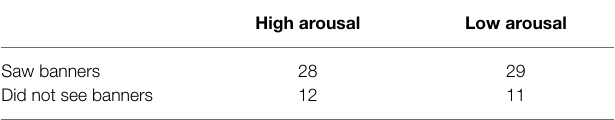
TABLE 2 | Summary table of found and missed banners with high and low arousal (cells contain the number of participants).